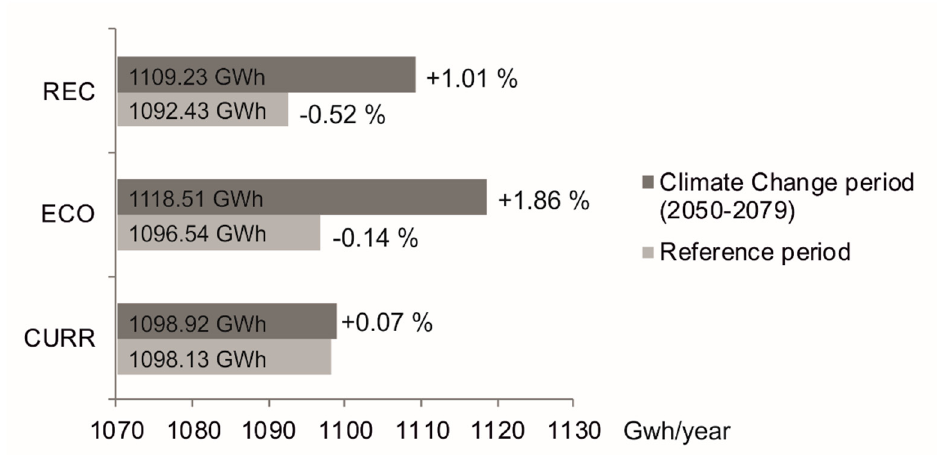
Figure 10. The energy production capacity (in GWh/a) of the control period and climate change period with different regulation alternatives. The values were calculated and applied in the study by Dubrovin et al. [51]. The difference of each case compared to the reference period with the current regulation rules (R CURR) is marked in the figure in percent. Note that the x-axis starts from 1070 GWh/a.